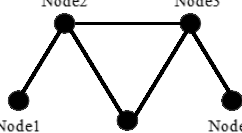
Figure 5. A typical studied graph.